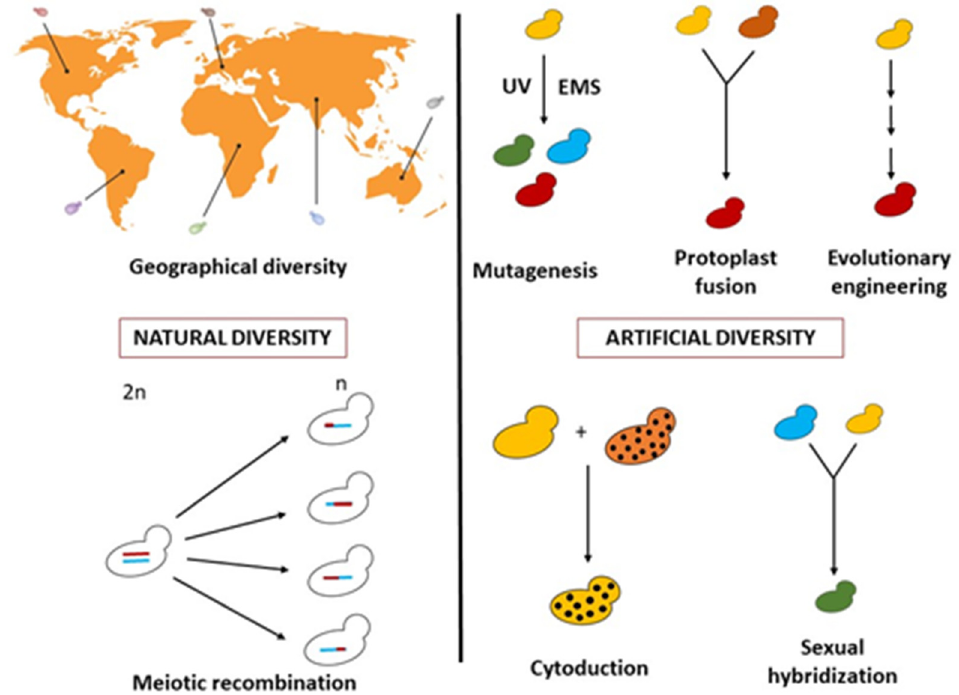
Figure 1. Methods for obtaining genetic variability in yeast adapted from Steensels et al. [18] (UV ultraviolet, EMS, ethyl methane sulfonate).